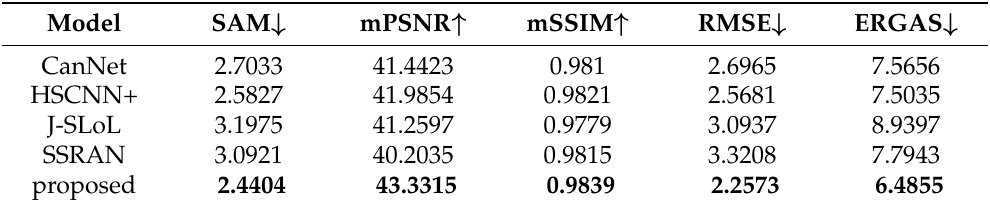
Table 2. Quantitative results of different methods using Pavia University dataset. “ ↓ ” means smaller is better for this index. “ ↑ ” means bigger is better for this